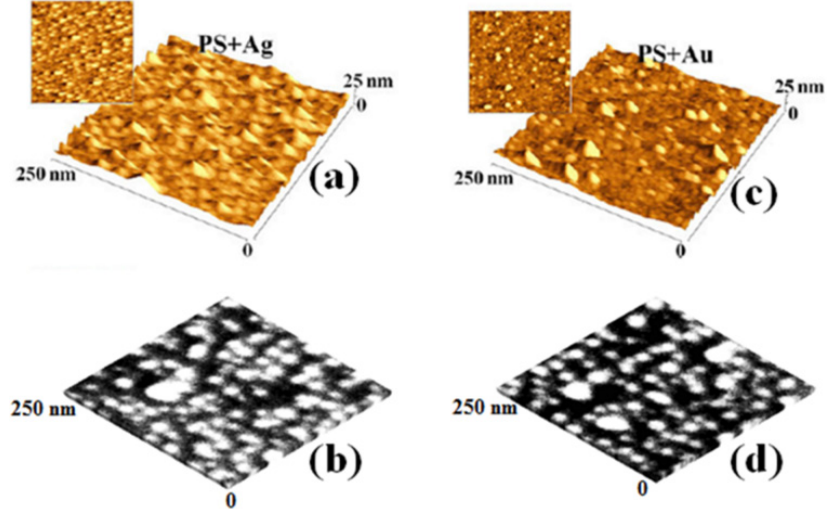
Figure 11. Representative two-dimensional and three-dimensional reconstruction of 0.25 μ m × 0.25 μ m AFM images of Ag ( a ) and Au ( c ) films deposited on PS. ( b ) and ( d ) report the correspondent SEM images. (Reproduced with permission from [65], Copyright Springer